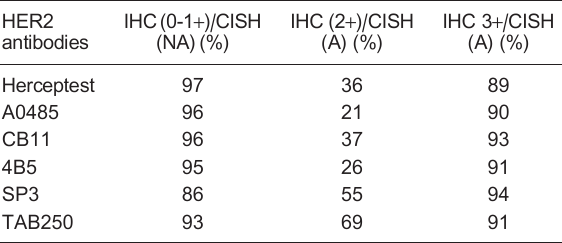
NA = non-amplification; A = amplification. For these compar- isons, 40 studies with available data (14-18,24,26-30,34-39,41- 51,53,55,57-65,68) were